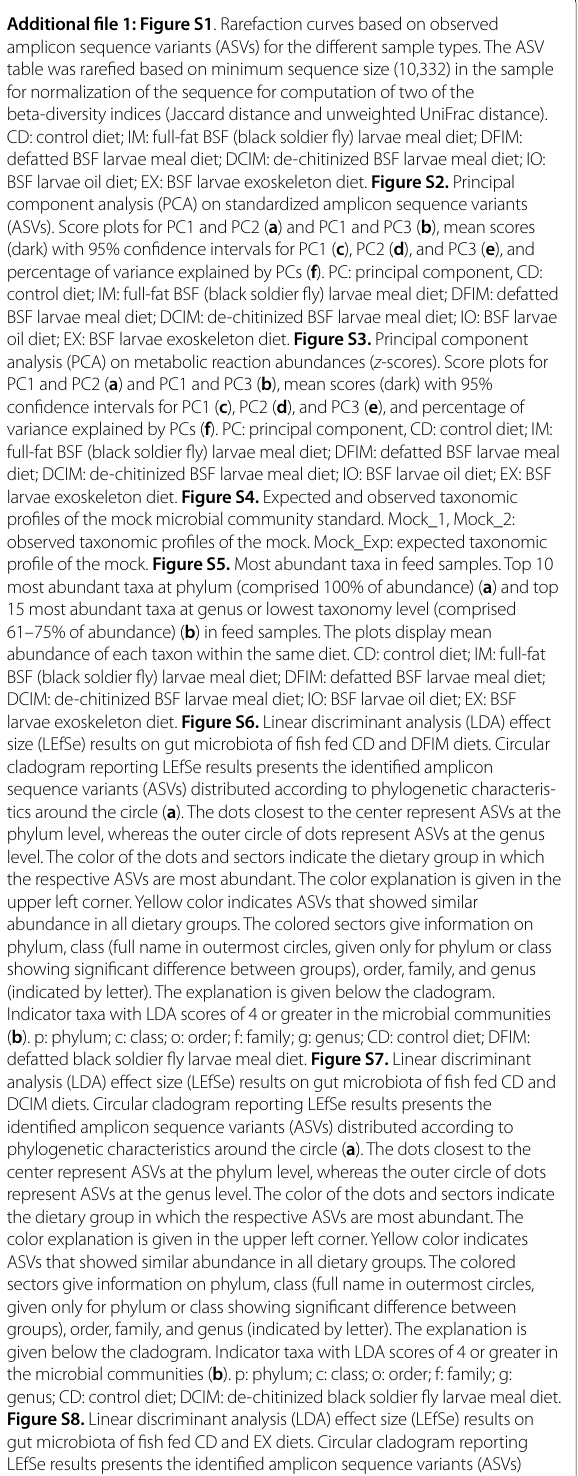
table was rarefied based on minimum sequence size (10,332) in the sample for normalization of the sequence for computation of two of the beta-diversity indices (Jaccard distance and unweighted UniFrac distance). CD: control diet; IM: full-fat BSF (black soldier fly) larvae meal diet; DFIM: defatted BSF larvae meal diet; DCIM: de-chitinized BSF larvae meal diet; IO: BSF larvae oil diet; EX: BSF larvae exoskeleton diet. Figure S2. Principal component analysis (PCA) on standardized amplicon sequence variants (ASVs). Score plots for PC1 and PC2 ( a ) and PC1 and PC3 ( b ), mean scores